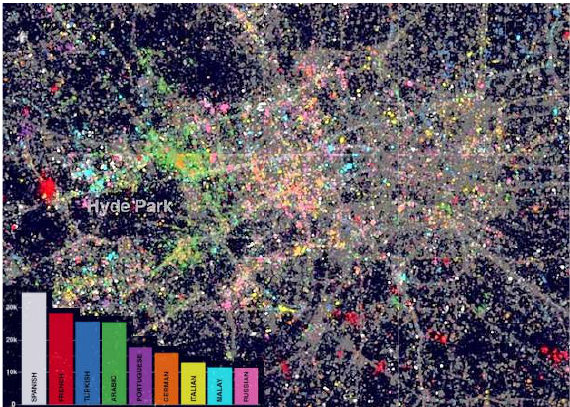
Figure 9: Tw are shown in